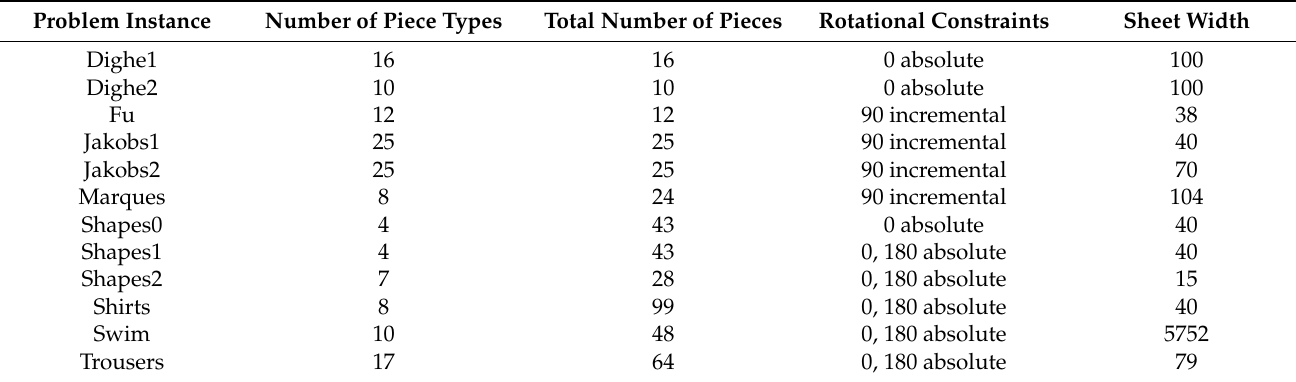
Table 1. Details of the benchmark problems.